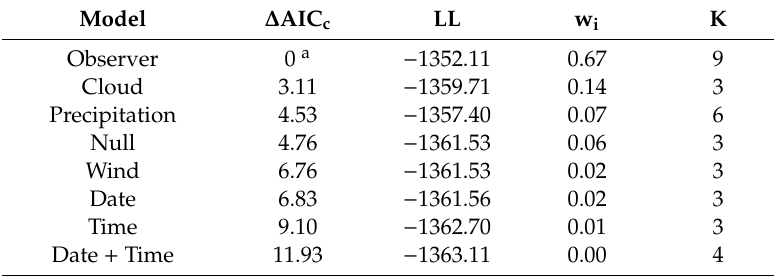
Table 2. Candidate models explaining detectability of rusty blackbirds in Newfoundland, Canada, in 2016 and 2017 ( n = 1960 survey